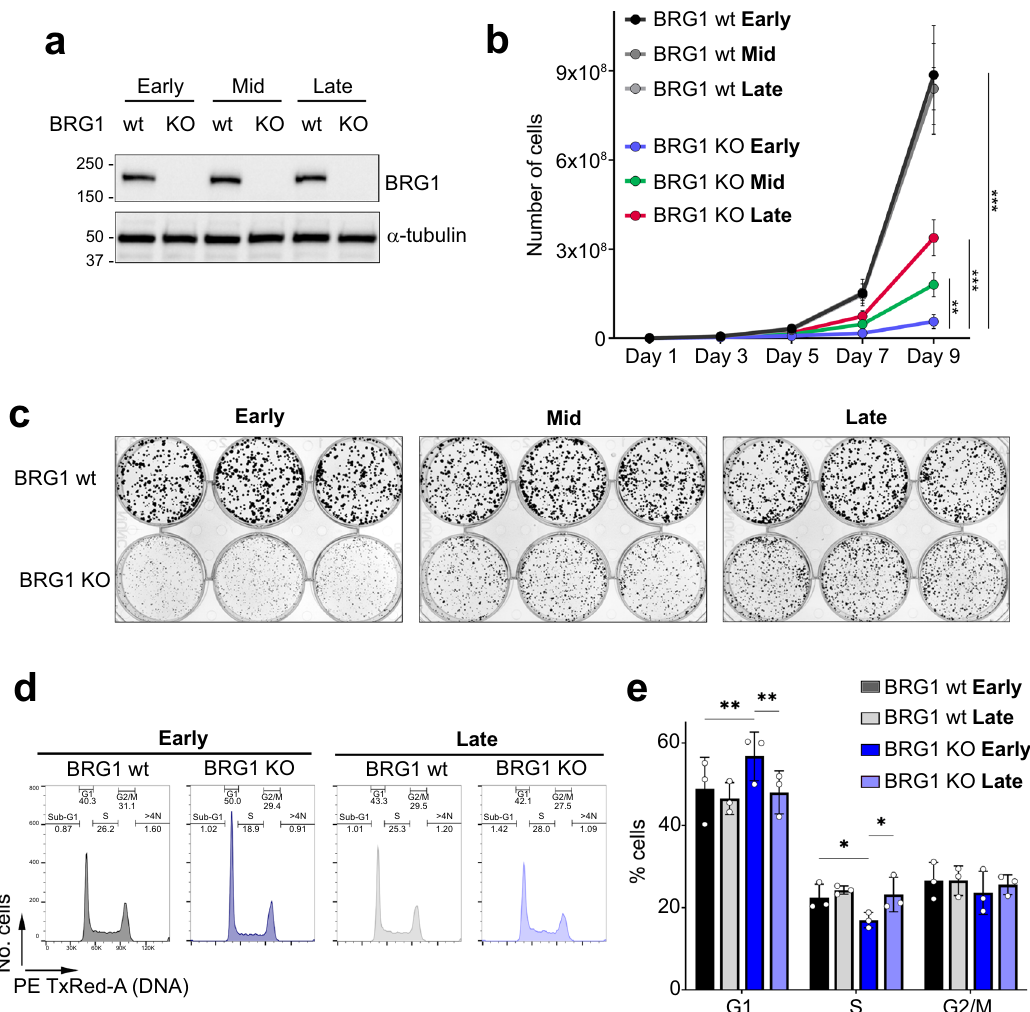
Fig. 2 The fi tness of BRG1-de fi cient cells improves over time. a Western blot analysis of BRG1 in whole-cell extracts prepared from HCT116 and BRG1- de fi cient (KO) clone 2 cells at early, mid (4 months) and late (8 months) time points. α -tubulin was used as a loading control. Similar results were obtained in three independent repeats. b The proliferation rate of BRG1 knockout clone 2 improves during long-term cell culture. Cell number was monitored every 2 days over a period of 9 days in HCT116 and BRG1 KO clone 2 cells taken from early, mid (4 months) and late (8 months) time points. Data were presented as the mean ± SD; n = 3. The p value was calculated with two-way ANOVA-Tukey. ** p < 0.01, *** p < 0.001. c The colony size of BRG1 knockout clone 2 increases during long-term cell culture. Clonogenic assay showing the colony size of HCT116 (BRG1wt) and BRG1 knockout (KO) cells taken from early, mid (4 months) and late (8 months) time points. d The cell cycle pro fi le of BRG1-de fi cient cells changes during long-term cell culture to a pro fi le similar to parental HCT116 cells. Representative fl ow cytometry pro fi les in HCT116 and BRG1-de fi cient cells (clone 2) at early and late (8 months) time points. e Quanti fi cation of cells (%) in each cell cycle phase from fl ow cytometry pro fi les in HCT116 and BRG1 knockout clone 2 from early and late (8 months) time points. Data were presented as the mean ± SD; n = 3. The p value was calculated with two-way ANOVA-Tukey. * p < 0.05, ** p <